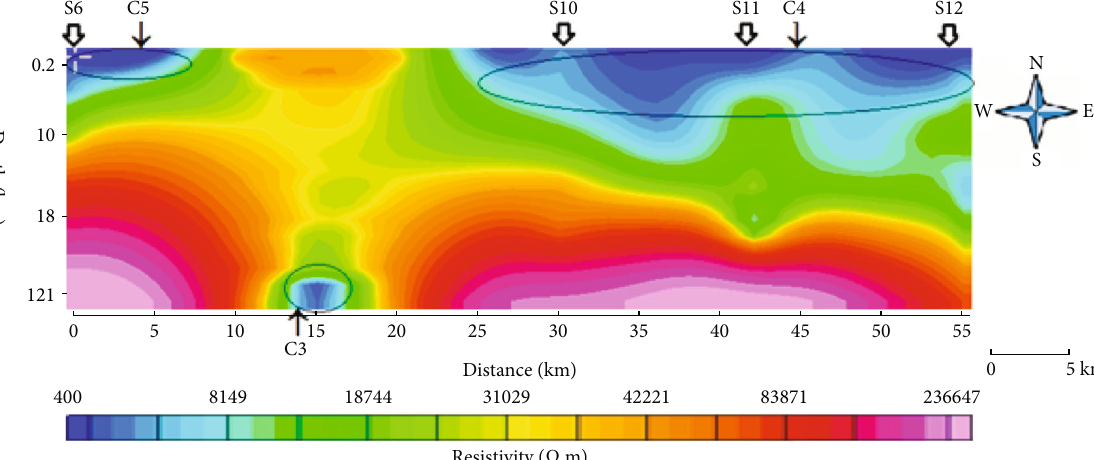
Figure 6: 2D resistivity section of pro fi le P2.